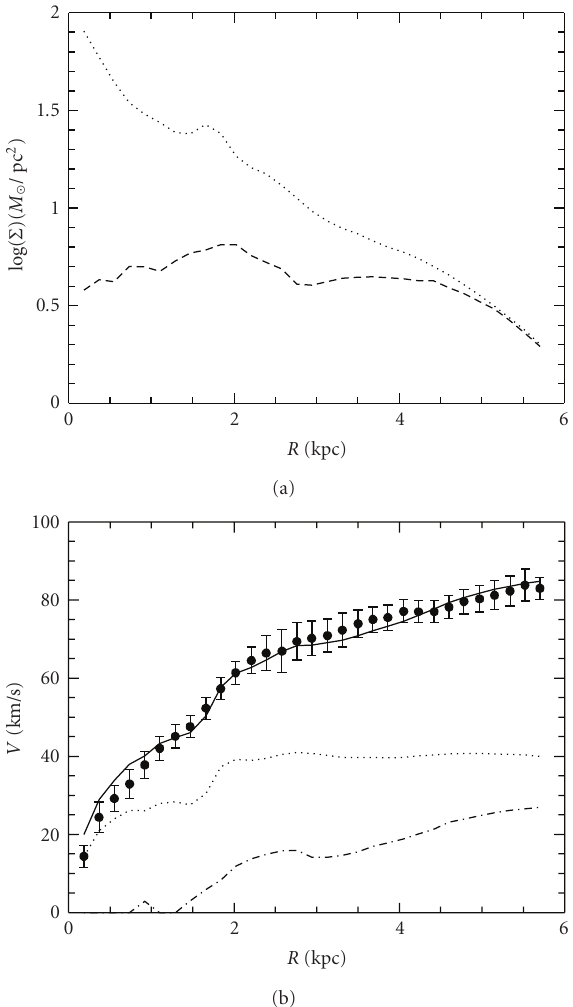
Figure 6: (a) The mass surface density distribution in stars and gas (dotted and dashed curves) as a function of radius for the low surface brightness dwarf, UGC 7524. (b) The corresponding Newtonian and the MOND rotation curves (dotted, dashed, solid). The points are the observed curve